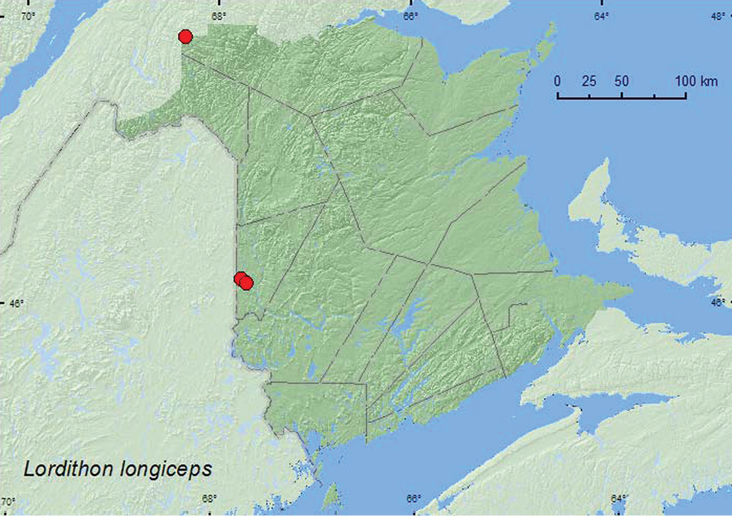
Collection localities in New Brunswick, Canada of Lordithon longiceps.